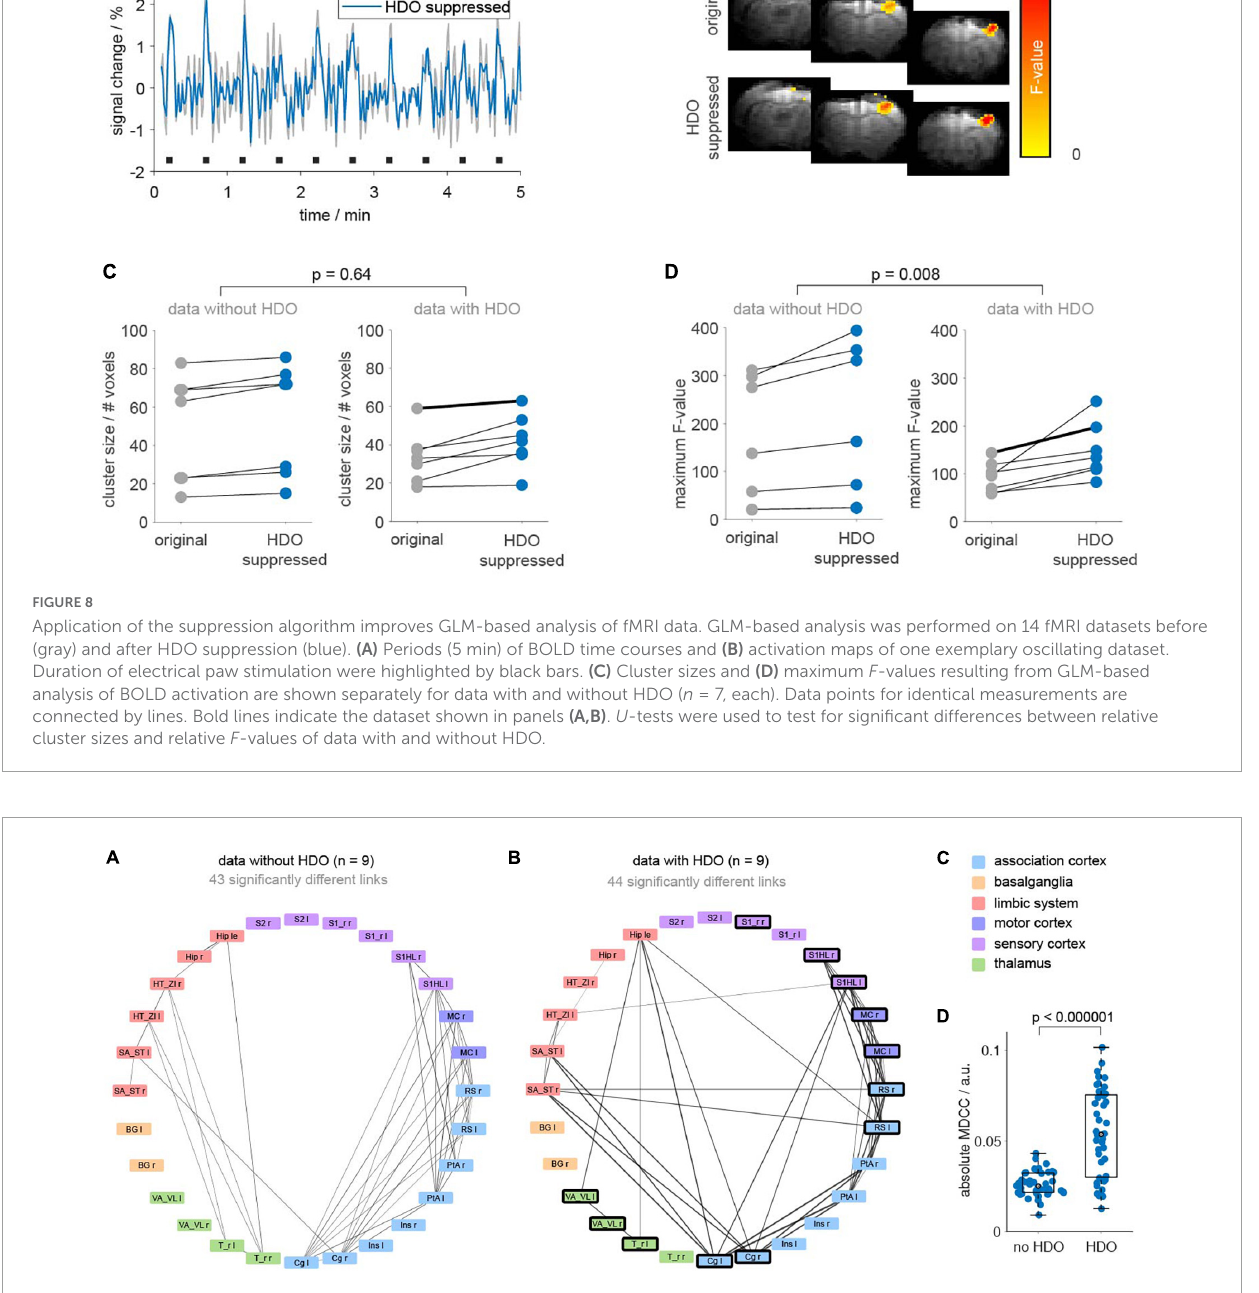
FIGURE9 Hemodynamic oscillations elimination in fMRI data improves NBS network analysis. Brain network analysis was performed before and after application of the HDO suppression algorithm and compared using NBS. Significantly different links were displayed in circular layout, separately for (A) non-oscillating and (B) oscillating data ( n = 9, each). Line thickness is proportional to absolute mean differences of correlation coefficients (MDCC). Nodes where HDO were frequently detected were highlighted (bold frame). (C) Brain regions were arranged and color coded by affiliation to six anatomical groups. (D) Absolute MDCC of oscillating data were significantly larger than for non-oscillating data ( U